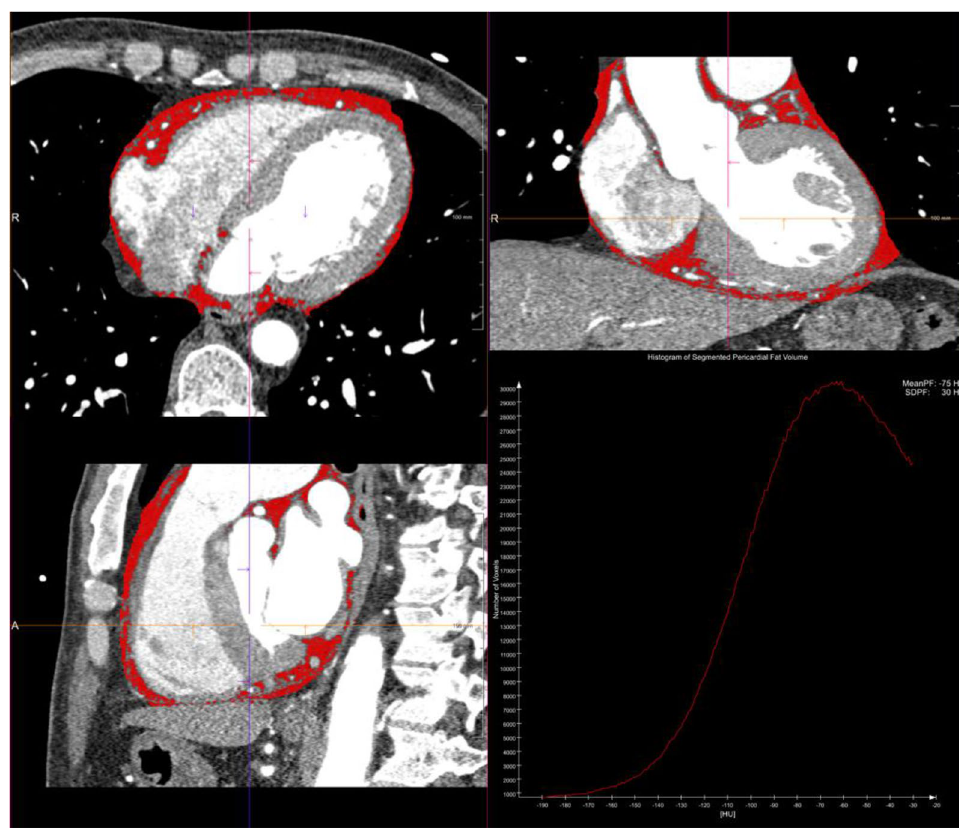
Figure 2. Epicardial adipose tissue (EAT) quantification. Measurement of EAT volume and radiodensity by automated software. EAT is highlighted in